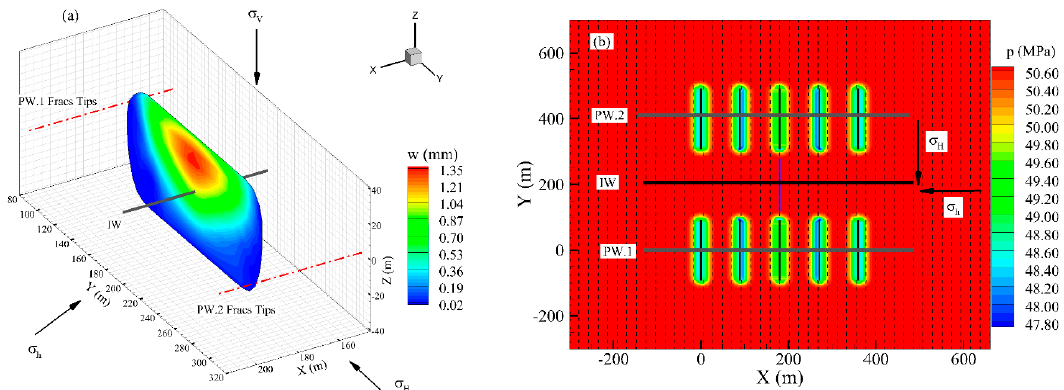
Figure 24. Infill well fracture propagation after repressurization of the production well fractures in the normal faulting stress regime: ( a ) propagated fracture geometry, ( b ) plan-view of the propagated fracture geometry on top of the reservoir pore pressure plot. The infill well fracture shows symmetric growth towards production wells and asymmetric growth in the vertical direction (i.e., z -axis) due to the in-situ stress gradient.